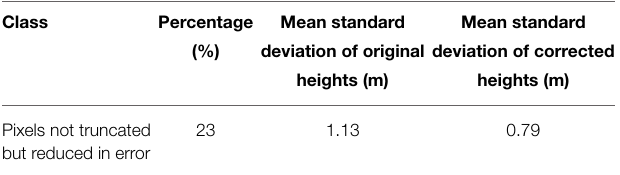
TABLE 3 | Errors for IDEM pixels between the waterlines not truncated but reduced in